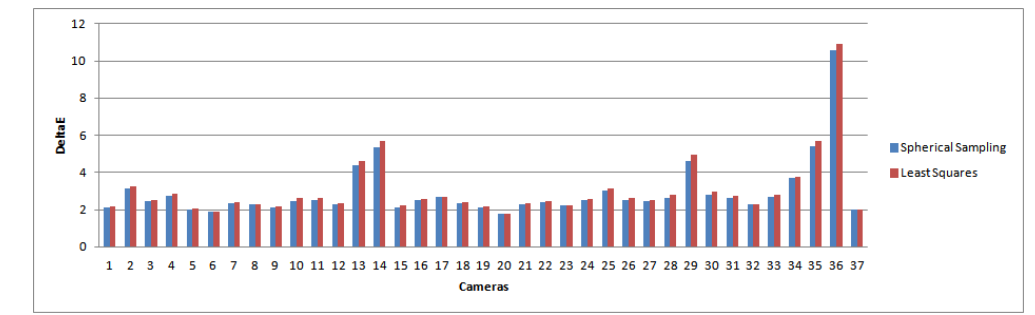
for spherical sampling; in red: 00